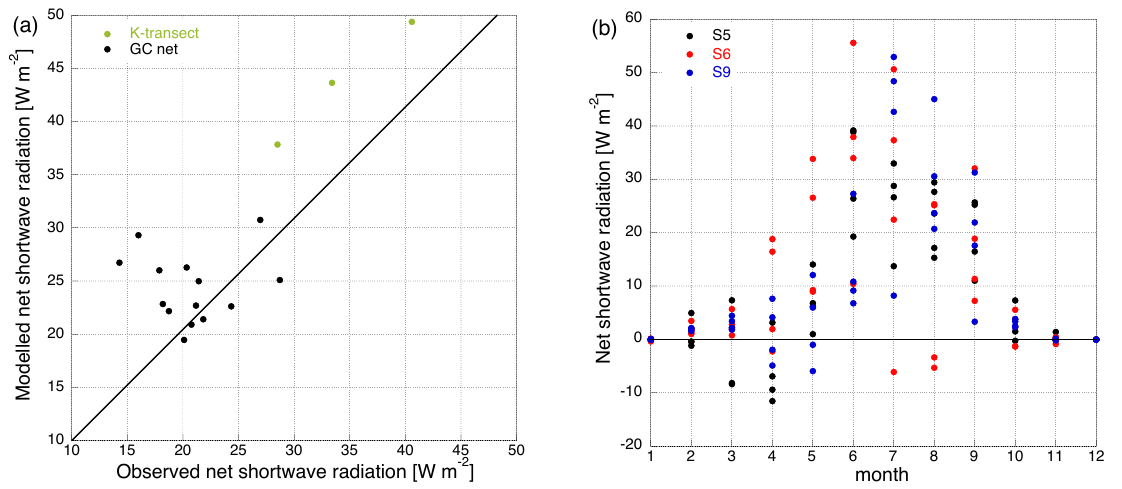
Fig. 11. Model performance for surface net shortwave radiation [Wm − 2 ] (a) model versus observations for GC-net (black) and K-transect (green) averaged over the available measuring period, (b) monthly model bias for S5 (black), S6 (red) and S9 (blue) over the period August 2003–August 2007.